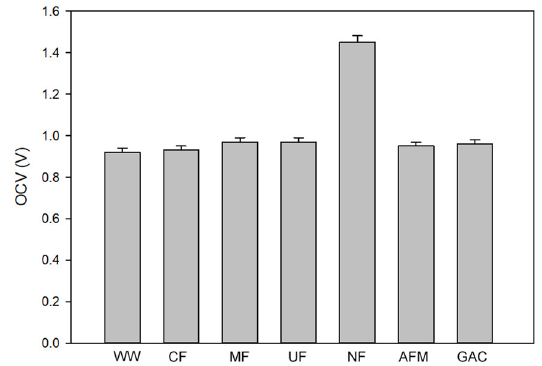
Figure 4. OCV values of RED system with different pretreatments (WW: raw feed solution; CF: cartridge filtration; MF: microfiltration; UF: ultrafiltration; NF: nanofiltration; AFM: activated filter media; GAC: granular activated carbon).